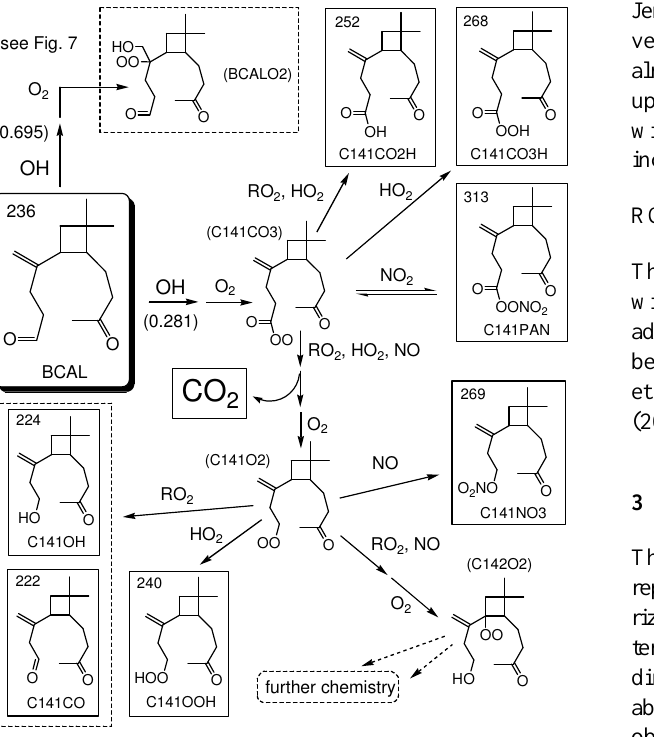
Figure 8. Schematic of the mechanism and selected products of the OH-initiated oxidation of 2 Fig. 8. Schematic of the mechanism and selected products of the E -caryophyllon aldehyde (BCAL), focusing on the chemistry following abstraction of the 3 OH-initiated oxidation of β -caryophyllon aldehyde (BCAL), focus- aldehydic H atom. The displayed values indicate the molecular masses of the products. 4 ing on the chemistry following abstraction of the aldehydic H atom. The displayed values indicate the molecular masses of the